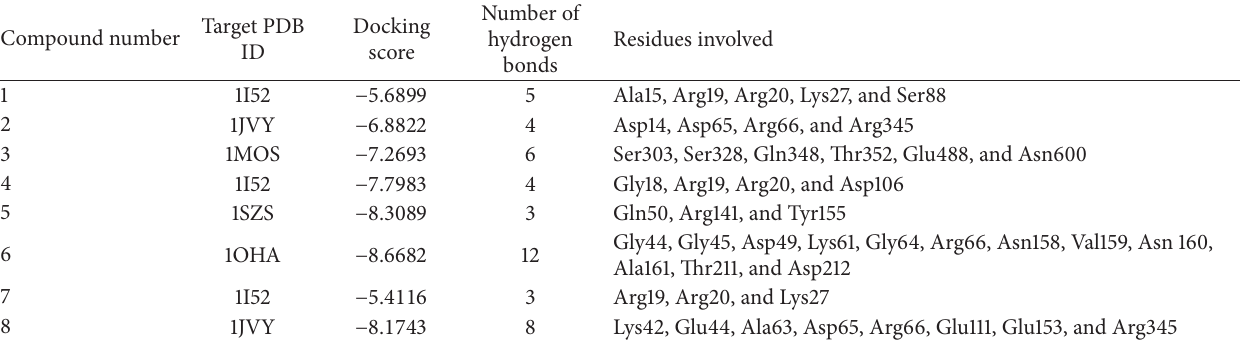
Table 5: Docking scores and interactions of Sanjin Tablets compounds to the predicted